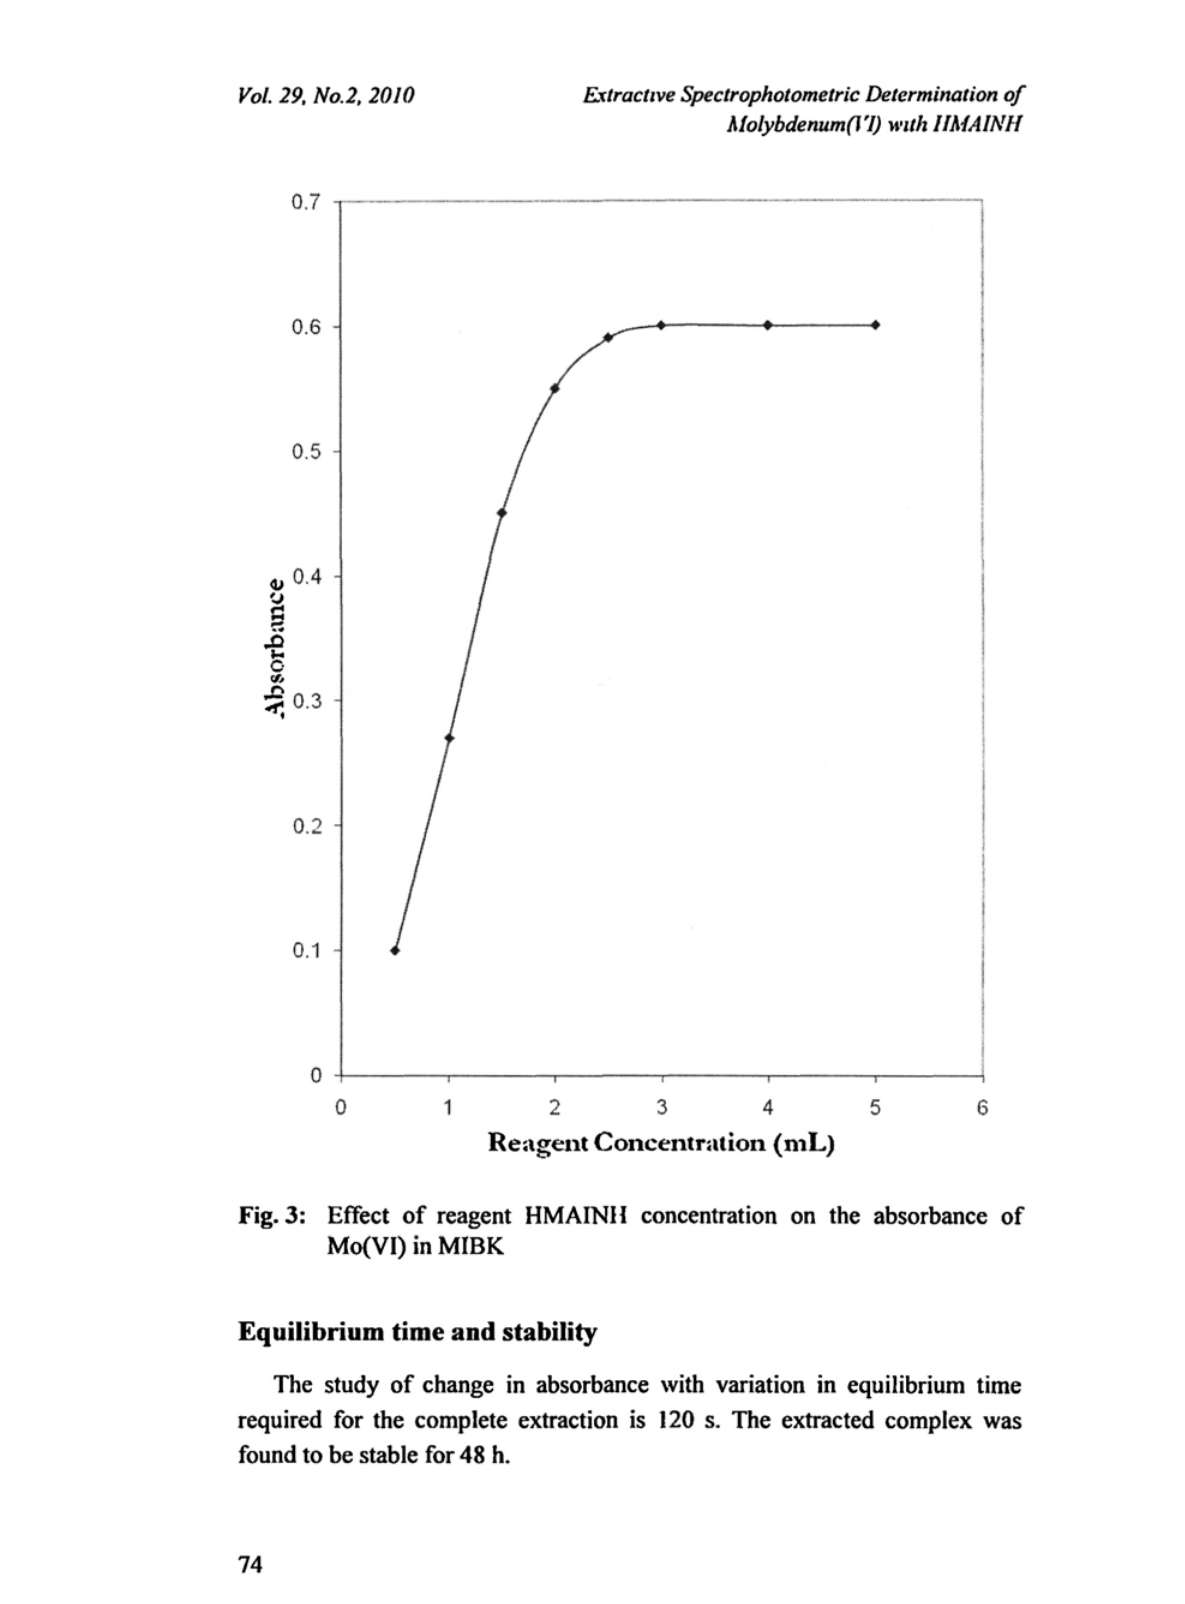
Fig. 3: Effect of reagent HMAINH concentration on the absorbance of Mo(VI) in